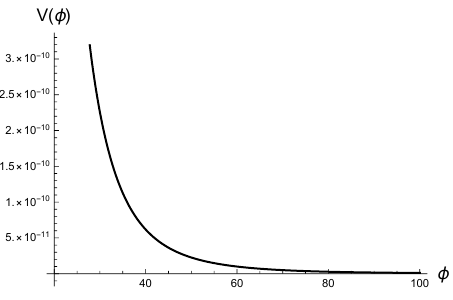
Figure 1 . Potential V ( (cid:30) ) from leading (cid:11) 0 correction with positive (cid:24) (i.e. negative (cid:31)